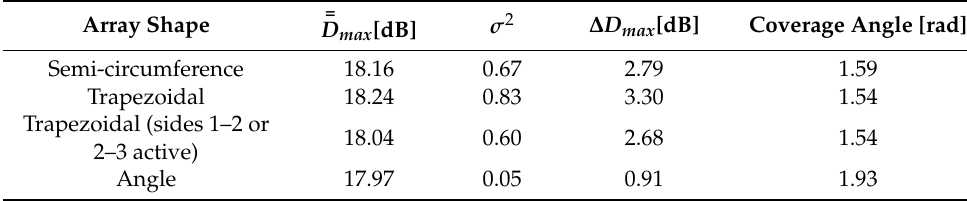
Figure 8. The amplitude of the field 𝐸(cid:3552)(cid:4666)𝜃(cid:4667) radiated by the semi-circumference array (solid blue lines), the trapezoidal array (dash-dotted yellow lines), the sides 1–2 of the trapezoidal array (dot- ted violet line), and the angle array (dashed red lines) of Figure 4. The plots present the field am- plitudes for the choice 𝐿 = 20𝜆 . From left to right, the three panels refer to the focusing angles 𝜃 (cid:2868) = 0, 𝜋/4, 𝜋/2 , respectively. 5. Conclusions The SVD of the radiation operator, numerically computed, provides the basic ele- ments (left singular functions and NDF) necessary for a deep analysis of the directive be- havior of a conformal array. This paper has shown that the resulting knowledge about the maximum directivity can be exploited to select the array shape that better meets some prescribed requirements. In particular, the capability of a given array to guarantee a